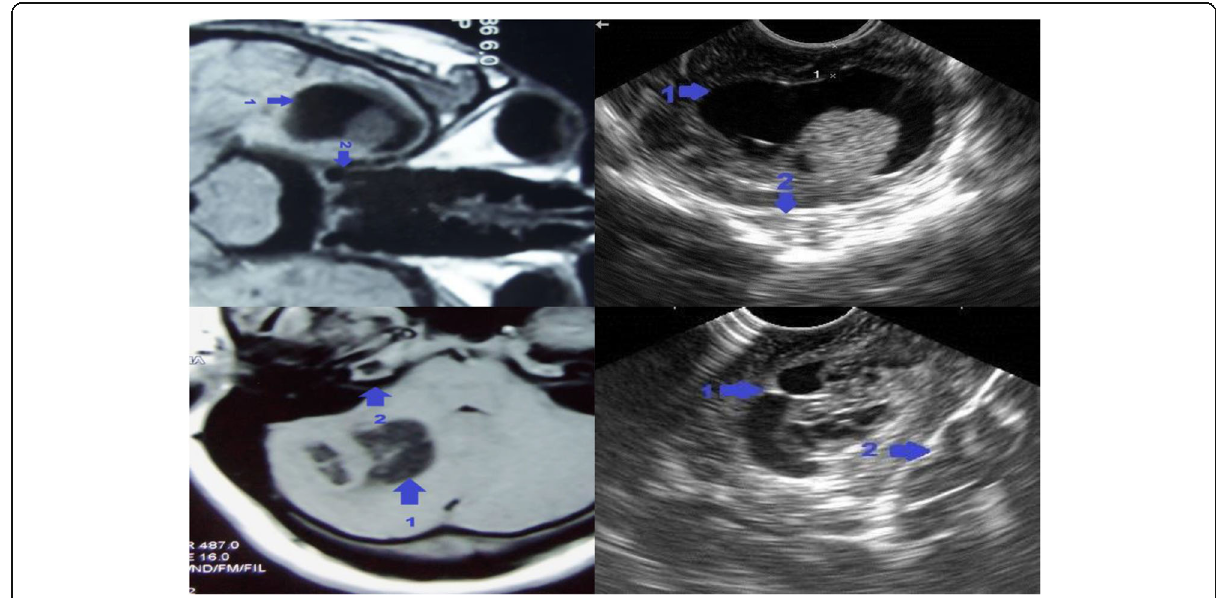
Fig. 1 Bone; arrow1 brain mass lesion, arrow2 bone (homogeneous